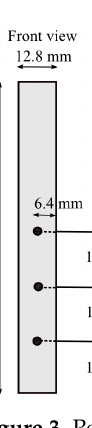
Figure 3. Position of the thermocouples